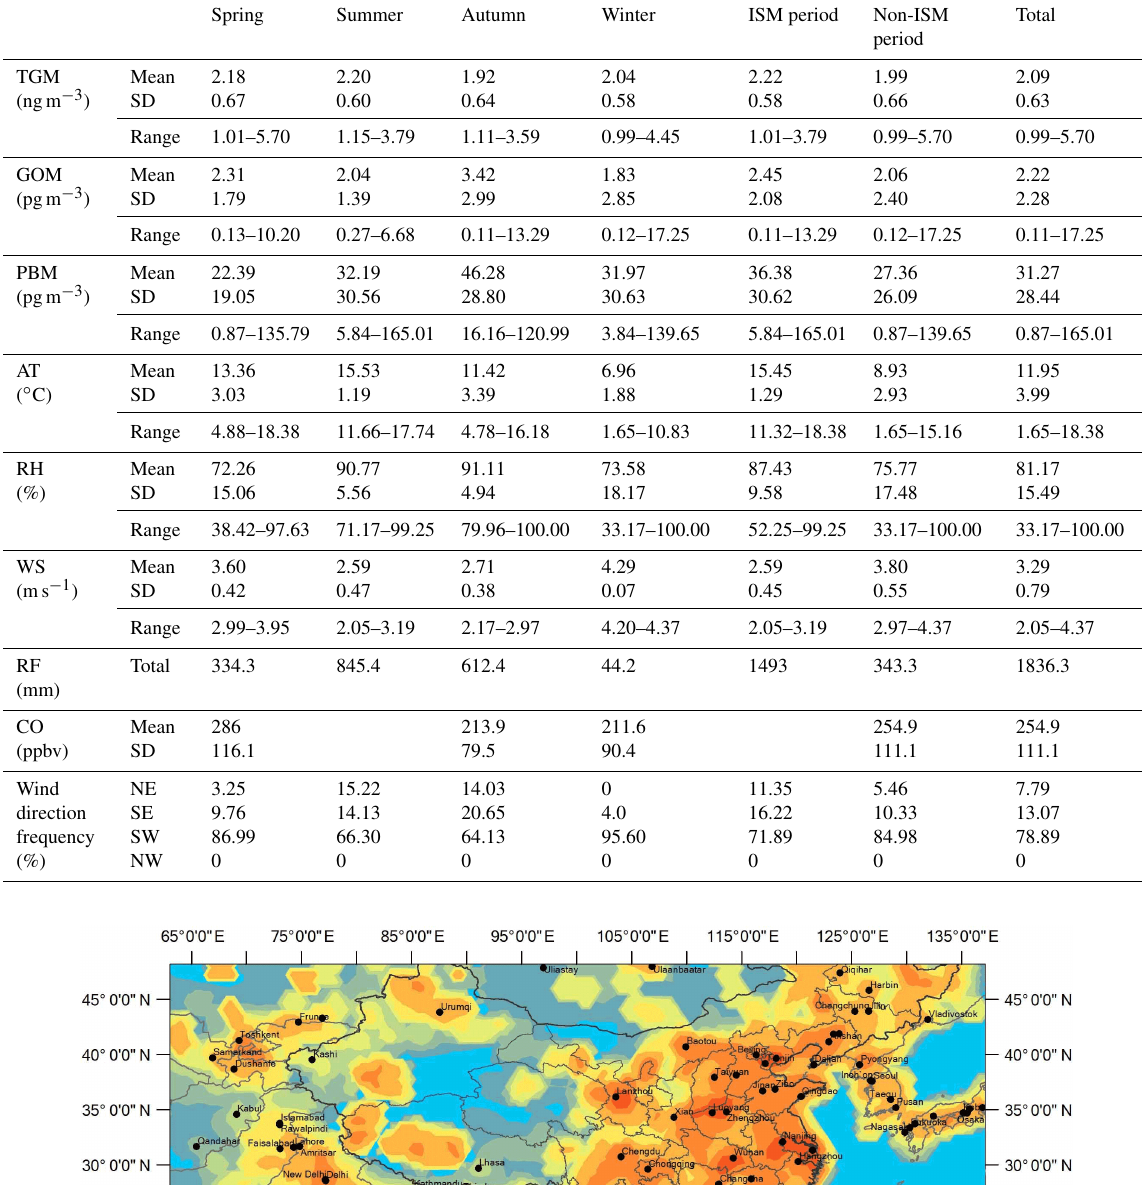
Table 1. The statistics for mercury species and meteorological variables based on daily averages from May 2010 through May 2011 at the ALS site.